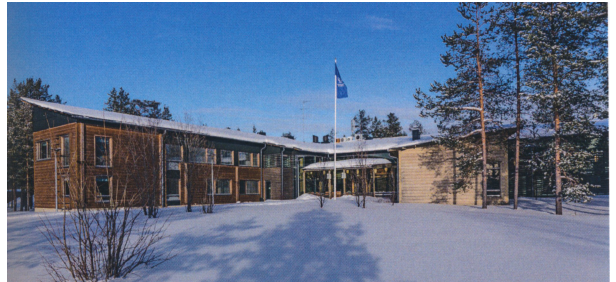
Figure 5. The joint main building – which goes by the name of Polaria – of the Sodankylä Geophysical Observatory and La- pland’s Research Institute of the Finnish Meteorological Institute. The building was completed in 2001 (photo by Thomas